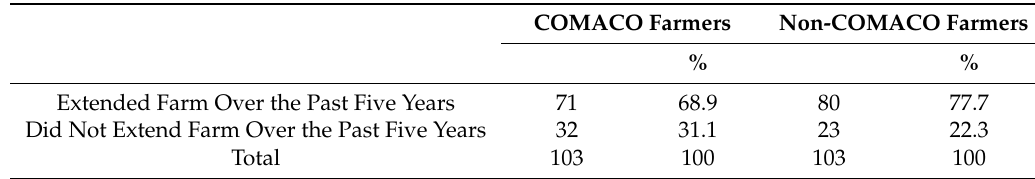
Table 2. Differences in Agricultural Extensification.